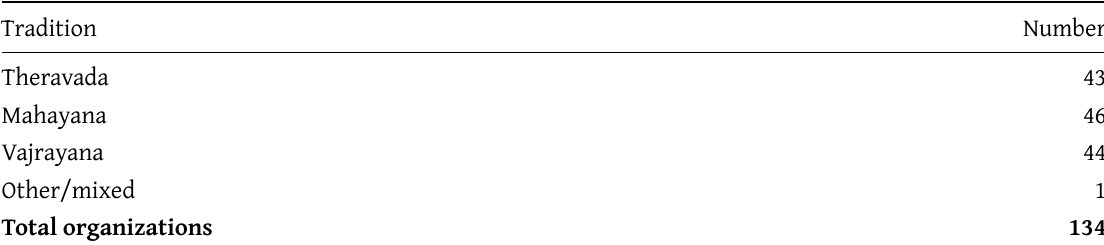
Table 5: Number of Buddhist Organizations (including Affiliates, Groups, and Centers), 2021.